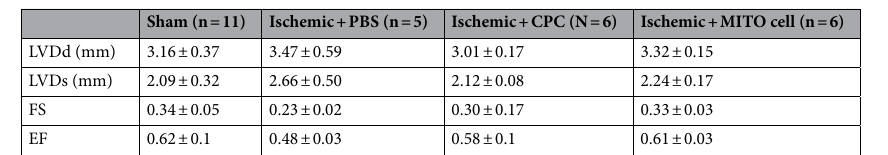
Table 2. Comparison of fraction shortening by two-dimension echocardiography. Left ventricular cardiac function was evaluated by measuring LVDd, LVDs and FS by echocardiography 30 days after treatment in each group. LVDd left ventricular end-diastolic diameter, LVDs left ventricular end-systolic diameter, FS fractional shortening, EF ejection fraction.